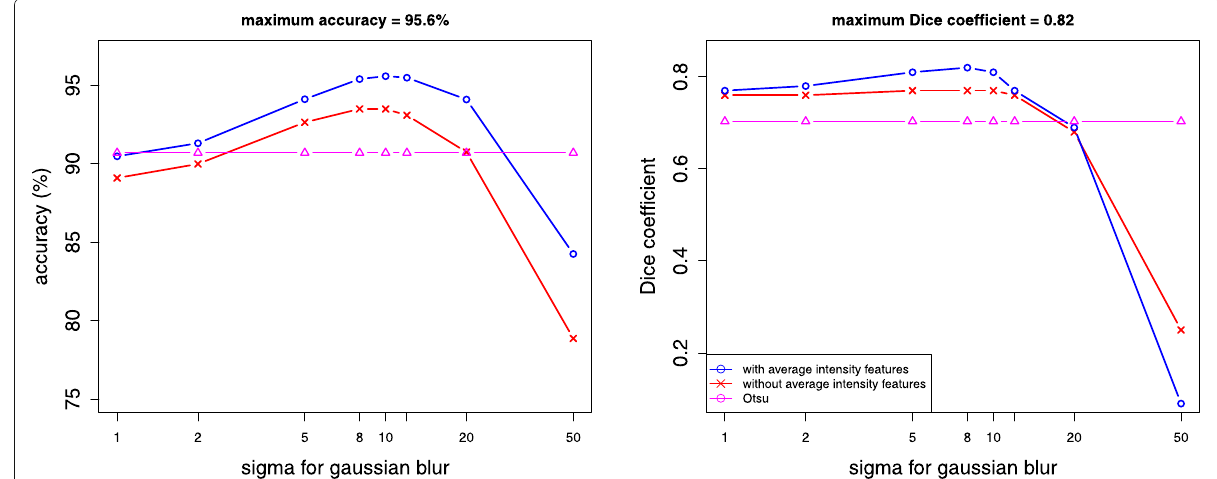
Fig. 3 Performance of the pixel classifier with and without average intensity features for different standard deviations of Gaussian blur. Also shown is the performance of Otsu segmentation the probability threshold, provided one takes a threshold between 2 to 5 times the estimated fraction covered by parasites.